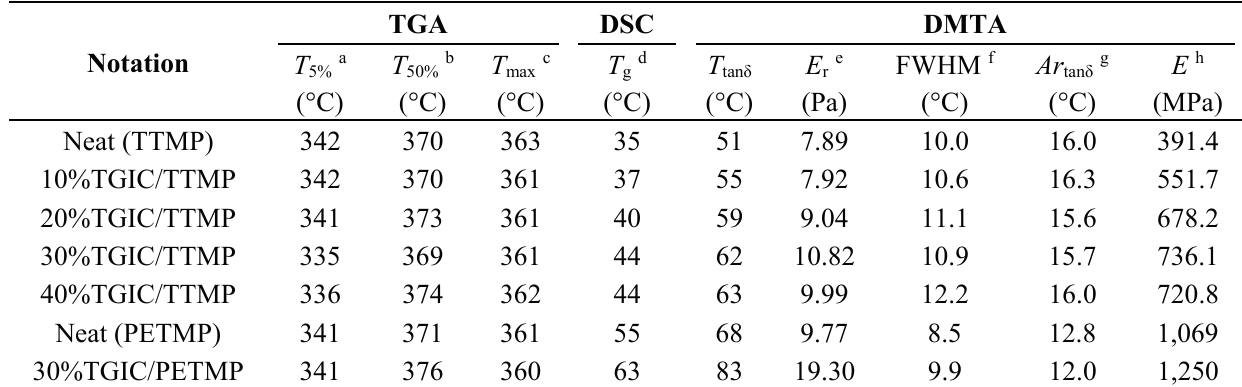
Table 2. Thermal data of the thermosets prepared.